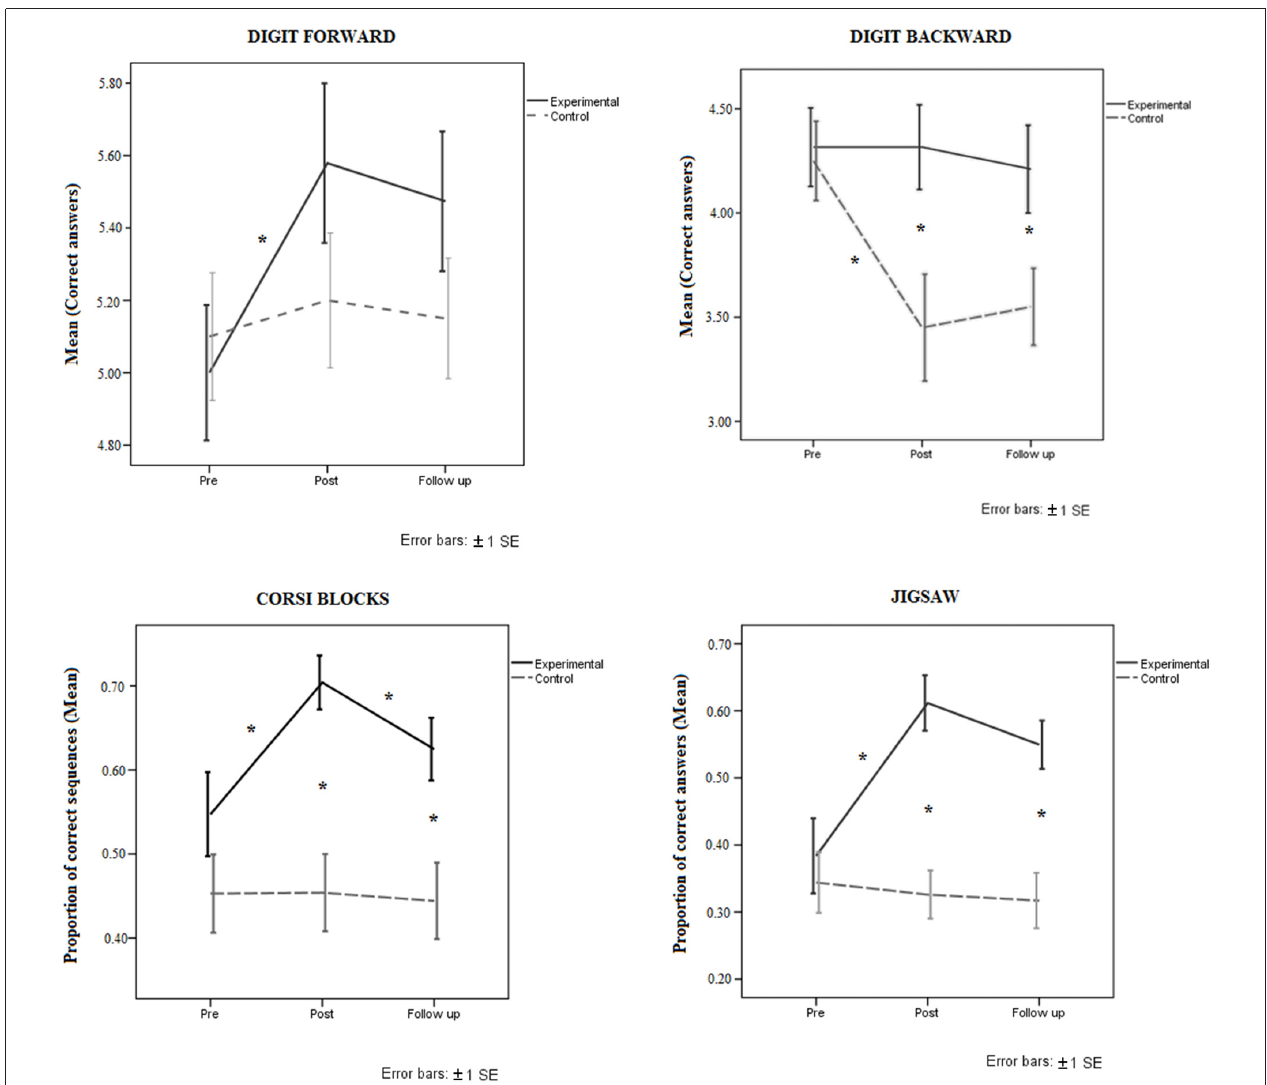
FIGURE 2 | Top: Mean performance of trained and control groups at pre-test, post-test and follow-up assessments in Digits forward (left) and Digits backward (right). Bottom: Mean performance of trained and control groups at pre-test, post-test and follow-up assessments in the working memory (WM) tasks (left: Corsi blocks; right: Jigsaw puzzle tasks). Error bars represent ± SE. ∗ p <